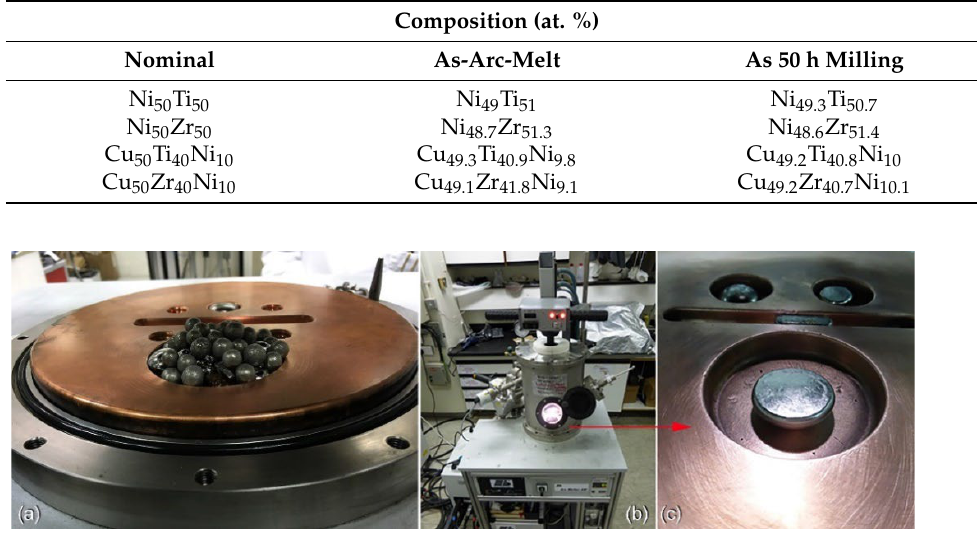
Figure 1. The arc melting process that was utilized to produce the binary and ternary alloys for this study can be seen in the photographs that were taken at the Nanotechnology Laboratory at KISR. ( a ) Elemental Cu, Zr, and Ti bulk materials with a nominal composition of Cu 50 Zr 40 Ni 10 were hosted into a copper open-hearth cooled with water; ( b ) melting procedure that was conducted with current and voltage of 250 A and 20 V, respectively, using W-metal electrode; ( c ) the outer surface appearance of the alloys after preparations.